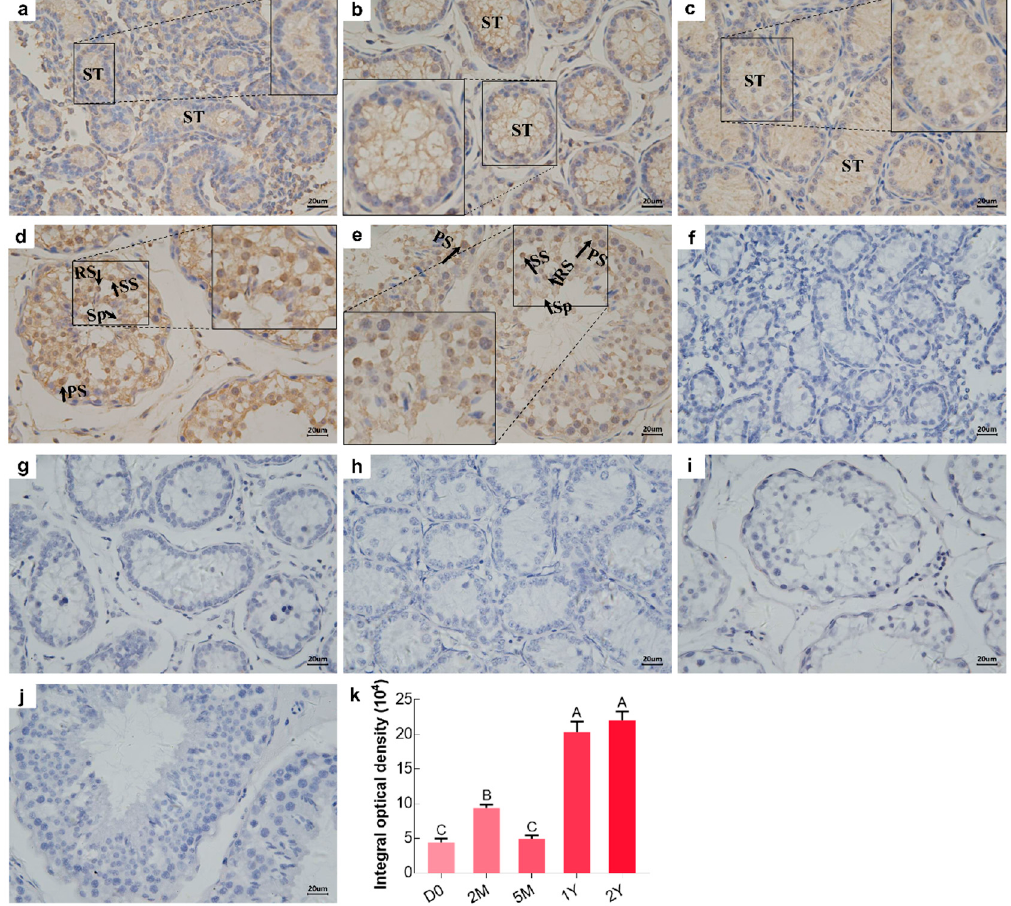
Figure 4. Immunohistochemical staining ( brown ) of BOLL protein in sheep testes at different developmental stages. ( a – e ) Immunostaining patterns of BOLL protein in the D0, 2M, 5M, 1Y, and 2Y sheep testes, respectively; ( f – j ) Substitution of PBS for the primary antibody served as a negative control; ( k ) Integral optical density of BOLL protein: ST, seminiferous tubule; S, spermatogonia; PS, primary spermatocyte; SS, secondary spermatocyte; RS, round spermatid; Sp, spermatozoa. The experiment was biologically replicated three times. Different capital letters denote an extremely significant difference between groups ( p < 0.01). D0: 0 days old; 2M: 2 months old; 5M: 5 months old; 1Y: 1 year old; 2Y: 2 years old. Scale bars, 20 μ m.